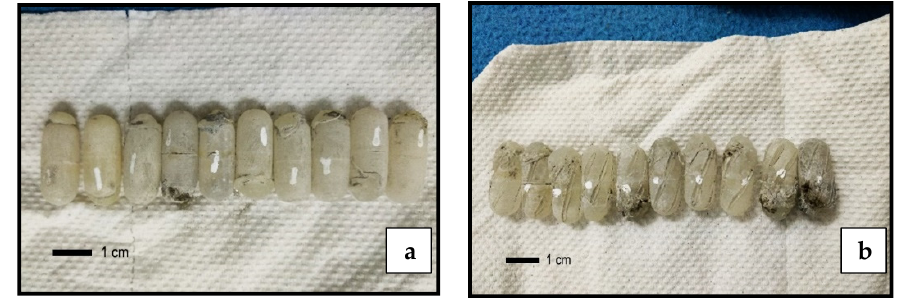
Figure 9. Capsules after mixing with high mixing speed level ( a ) rough capsules and ( b ) weak line capsules.